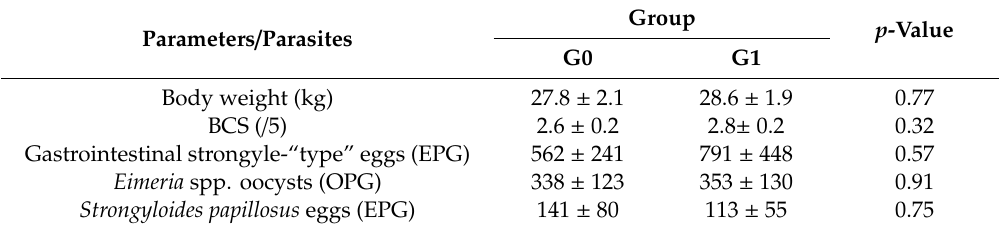
Figure 1. Energy ( a ) and protein ( b ) requirement, offered and ingested in sheep fed on C. nlemfuensis hay alone (G0) or G. ulmifolia foliage and C. nlemfuensis hay (G1). Calculations according to the INRA system. kJ: kilojoule, d: day, g: gram. Table 3. Mean weight, BCS, and parasitic loads of sheep offered hay of C. nlmenfuensis alone (G0) or supplemented with fresh foliage of G. ulmifolia (G1) (mean ± SE).